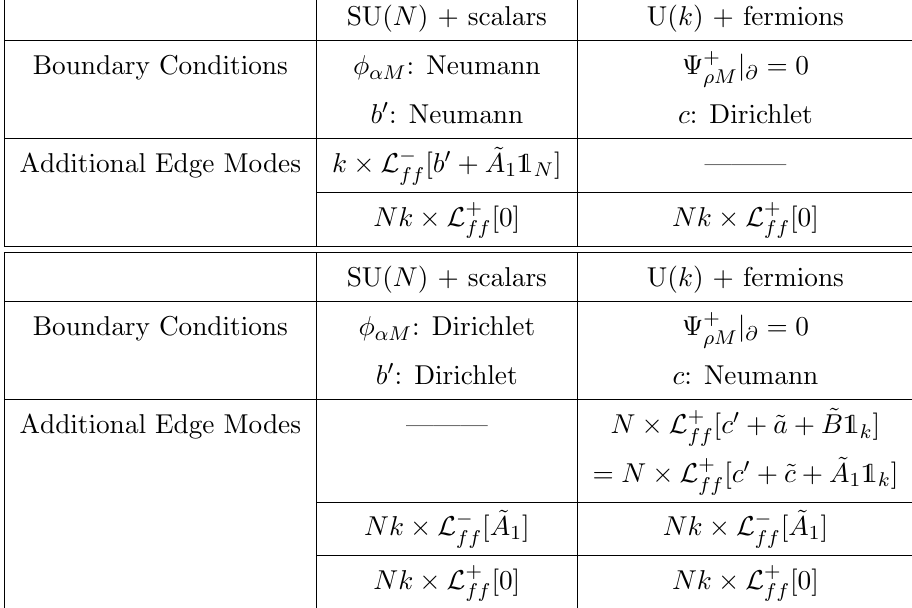
Table 3 . The top (bottom) table counts the additional edge modes when choosing Neumann and Dirichlet boundary conditions on the dynamical gauge (cid:12)elds in SU (U) and U (SU) side respectively when N f =